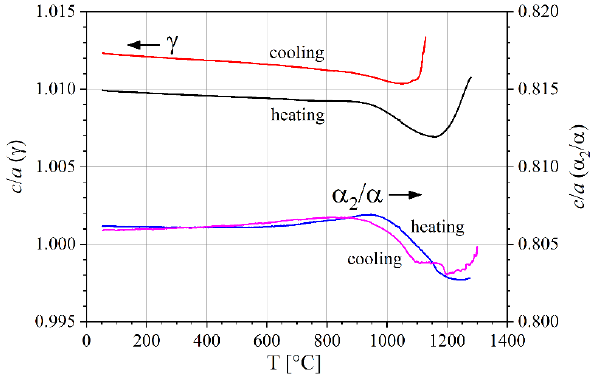
phase, c / a increases again above 1150 °C as shown in Figure 7.